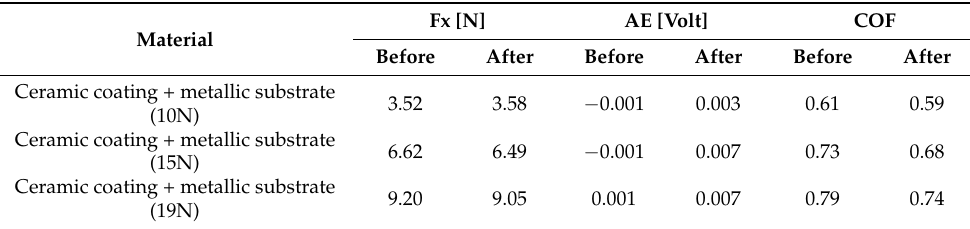
Table 4. Mechanical characteristics of the ceramic layer before and after the thermal shocks.